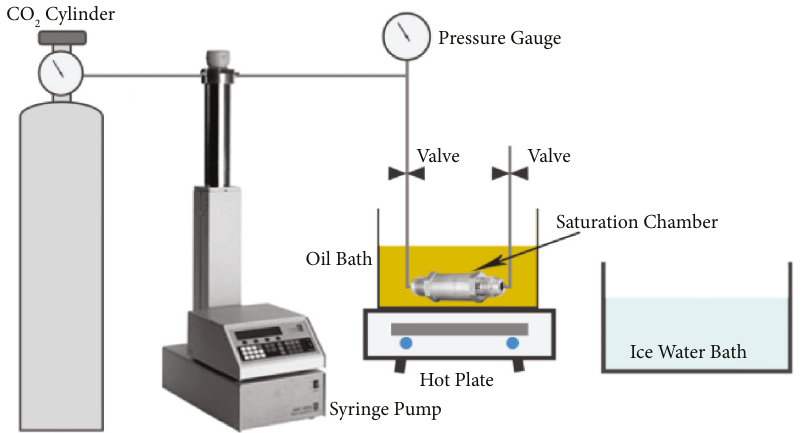
Figure 1: Supercritical CO